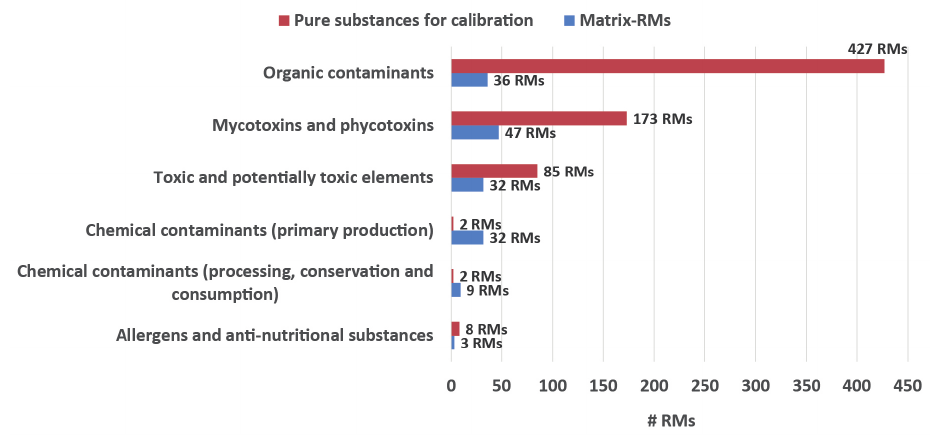
Figure 2. Current production of Reference Materials (RMs) for analysis of food contaminants. The available 2155 RMs consist of 900 Matrix-RMs and 1255 pure substances for calibration.